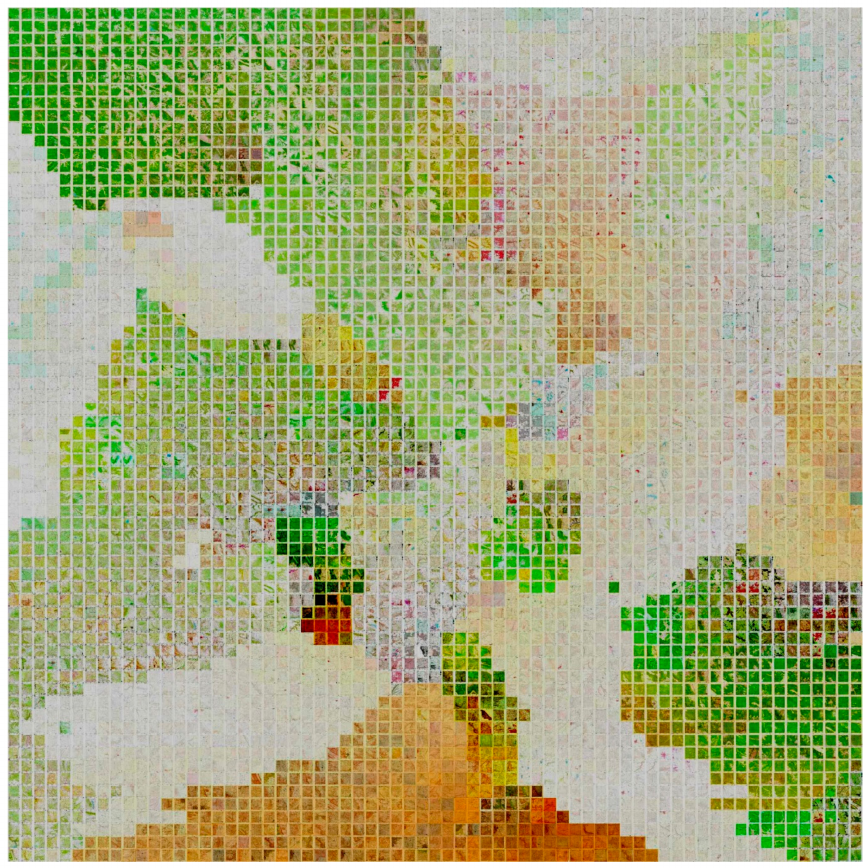
Figure 13. Thumbnail-based visualization of a subset of the USGS topographic maps in the state of Colorado (USA) based on a 2D transformation of the 12-dimensional image descriptor feature space using